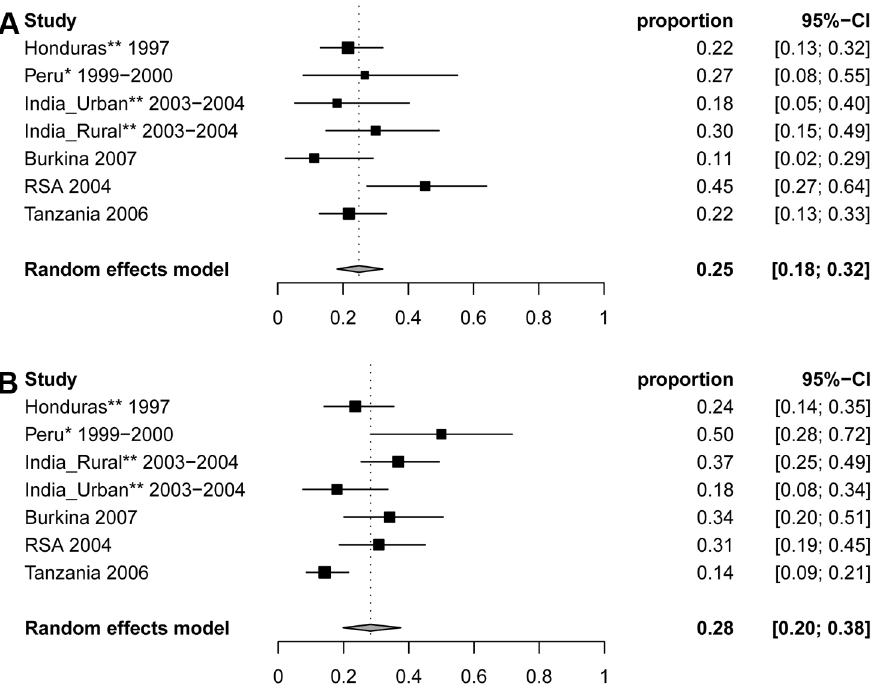
Figure 5. Forest plots of the proportion of NCC (95% CI) among people with epilepsy in children and adults. a) people aged between 0 and 19 years old and b) aged 20 years old or more. *Indicates studies among people with epilepsy and seizures. ** Indicates studies among people with active epilepsy only.